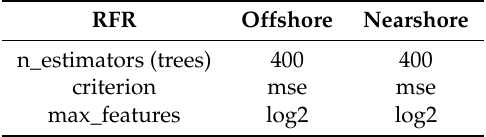
Table 1. Random Forest Regression parameters used other than